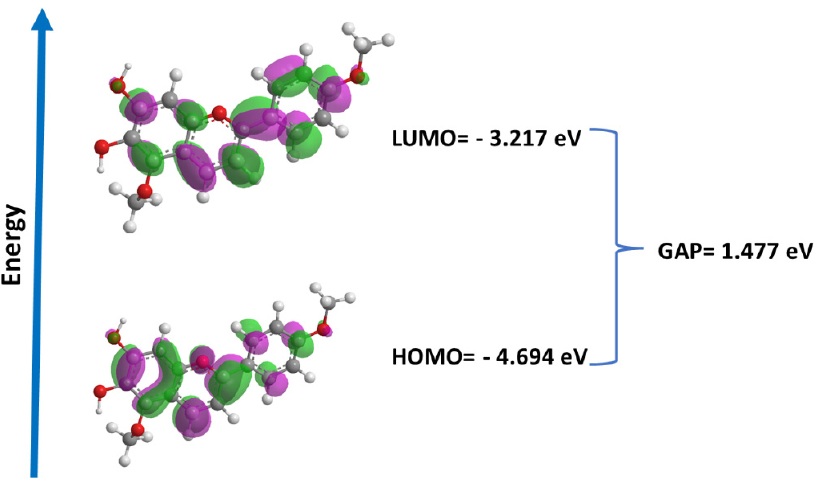
Figure 8. Energies and surfaces of the frontier orbitals (LUMO and HOMO) and GAP (LUMO-HOMO) for carajurin.